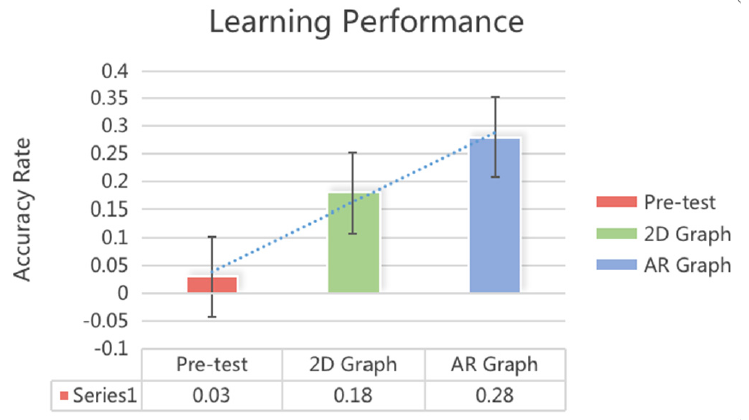
Figure 8. Learning performance between the pre-test and the post-test (2D graph and AR graph) (the dot line shows the growing trend among the learning performance).